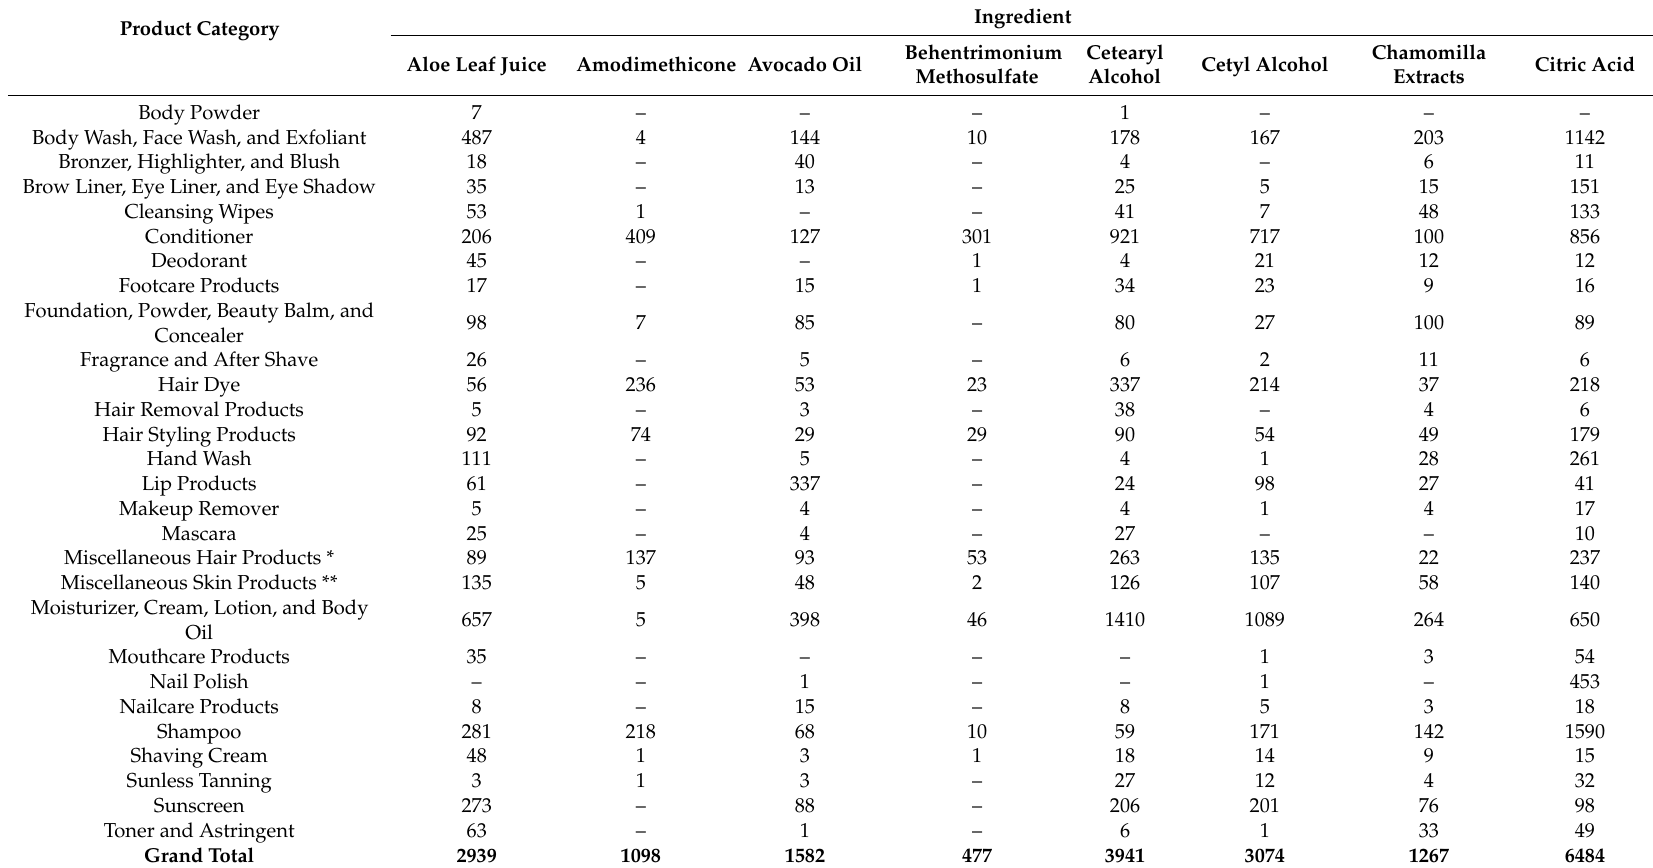
Table 2. Stratification of Ingredients by Product